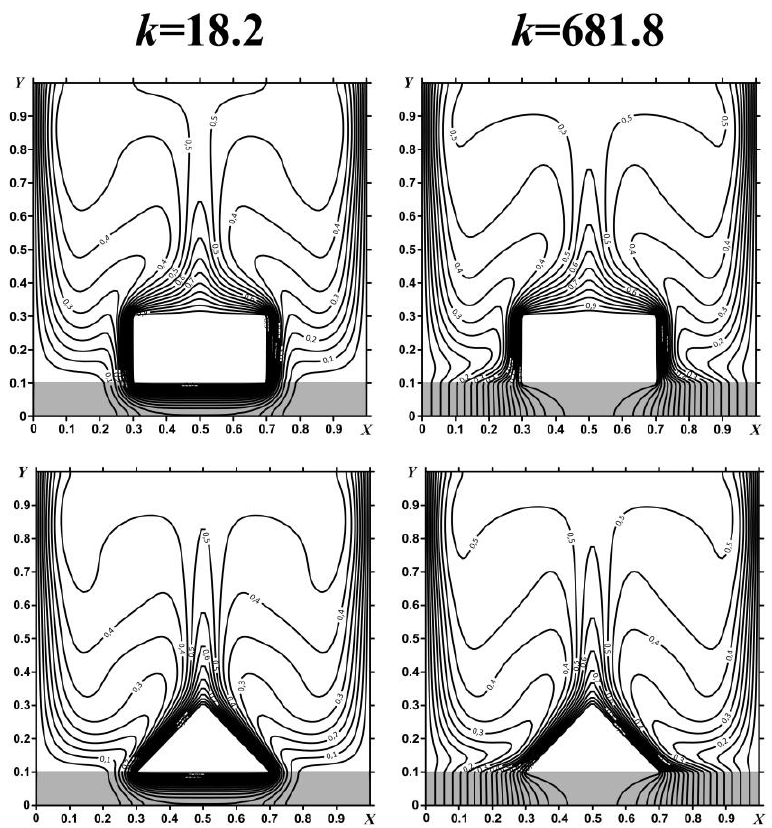
Figure 11. Isotherms at Ra = 10 6 for different shapes of heater and values at k .